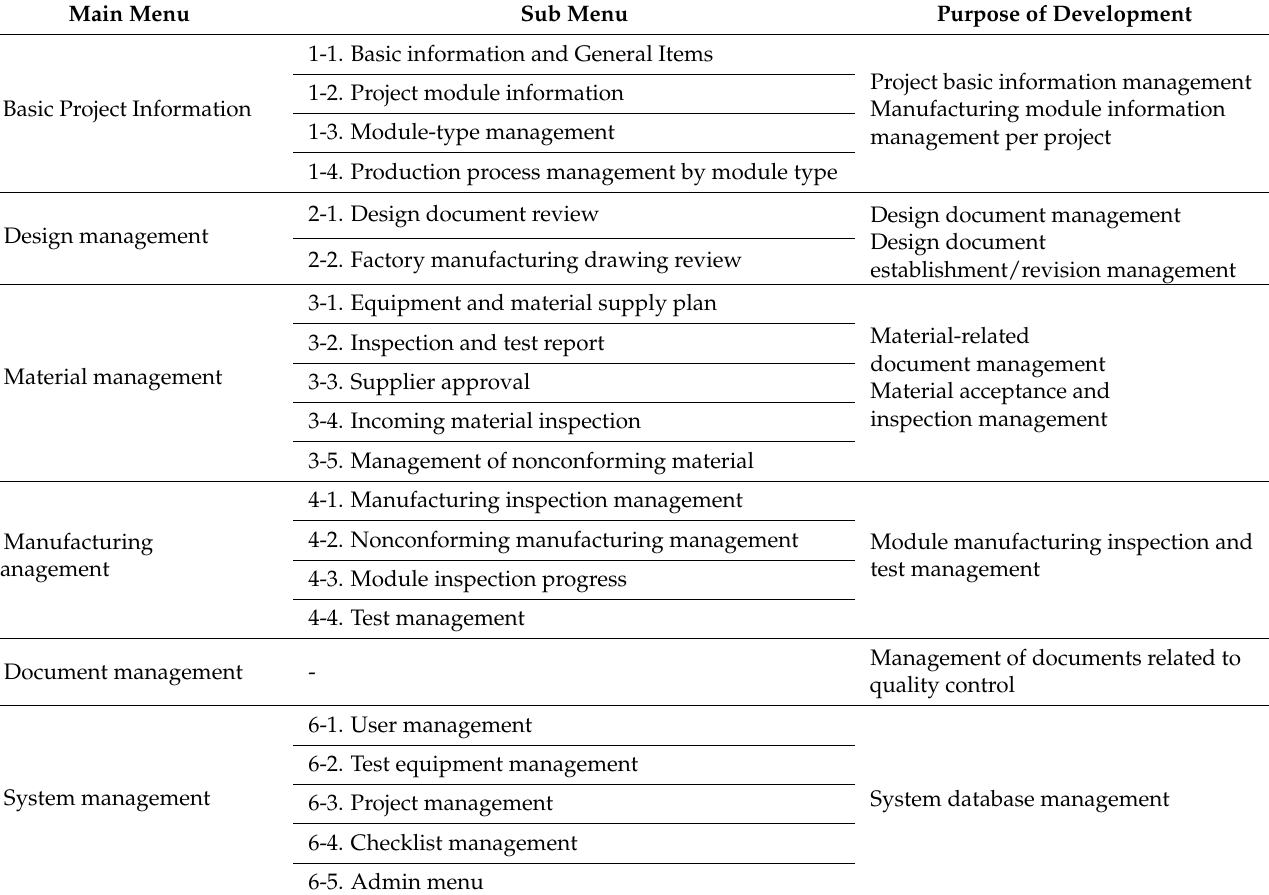
Table 2. Modular Factory Quality Information Management System